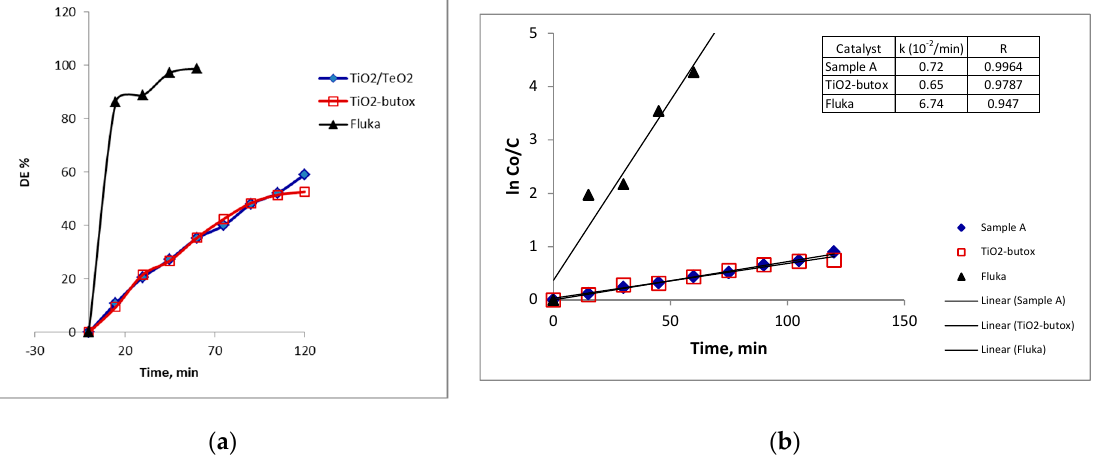
Figure 9. ( a ) Photodegradation efficiency of TiO 2 /TeO 2 , TiO 2 -butox and TiO 2 -Fluka samples in decoloration of MG under UV irradiation; ( b ) Photocatalytic reaction kinetics of MG decoloration by TiO 2 /TeO 2 , TiO 2 -butox and TiO 2 -Fluka samples.